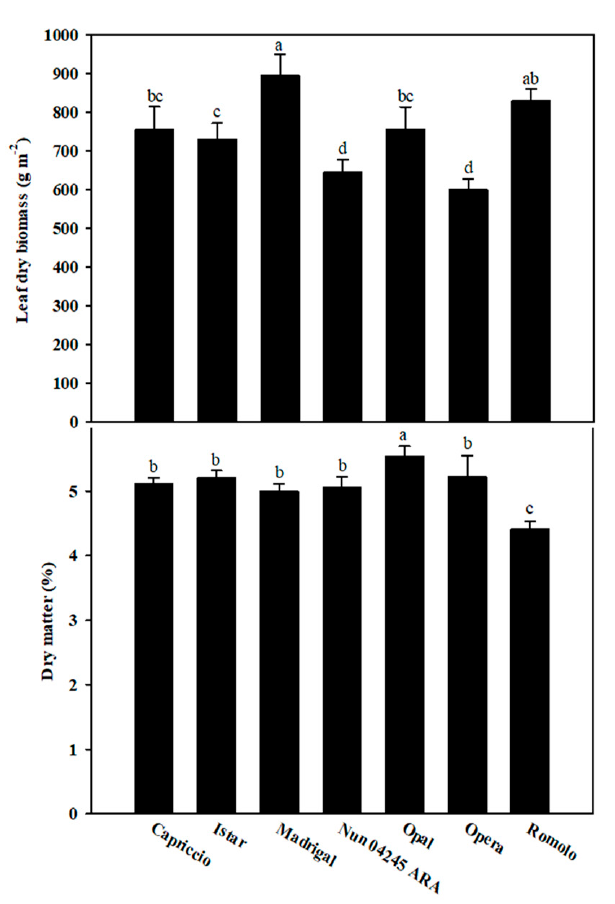
Figure 1. Leaf dry biomass and leaf dry matter content of seven artichoke cultivars grown in a floating raft culture. Each bar represents the mean ± standard deviation ( n = 3). For each bar, di ff erent letters indicate statistically di ff erent groups ( p < 0.05, Duncan’s post-hoc test following ANOVA; n = 3). − 2 The lower biomass ( < 650 g m ) was produced by ‘Nun 04245 ARA’ and ‘Opera’; the highest by ‘Madrigal’ and ‘Romolo’, the two late varieties (Figure 1). The average leaf biomass in the current study − 2 (745 g m ) was lower than that previously reported by Colla et al. [7] on three artichoke cultivars − 2 (‘Romolo’, Violetto di Provenza’ and ‘Violetto di Romagna’; avg. 1680 g m ). This variation probably reflects the di ff erent plant density (531 vs. 463 plants per square meter), the di ff erent growing season (autumn-winter vs. spring-summer), and the length of the cultivation period (62 vs. 100 days after sowing). The mean leaf dry matter of the seven artichoke cultivars was 5.1%, ranging from 4.4% in ‘Romolo’ to 5.5% in ‘Opal’ (Figure 1). The average leaf dry matter was lower than that previously reported (avg. 10.1%) [5]. For leafy vegetables, the products from soilless culture have a lower dry weight, although this does not necessarily result in a lower yield